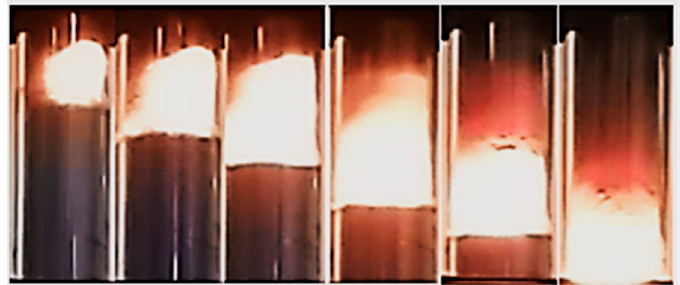
Figure 2. Propagation of the burning front during combustion of chromium powder in the co-flow filtration mode.